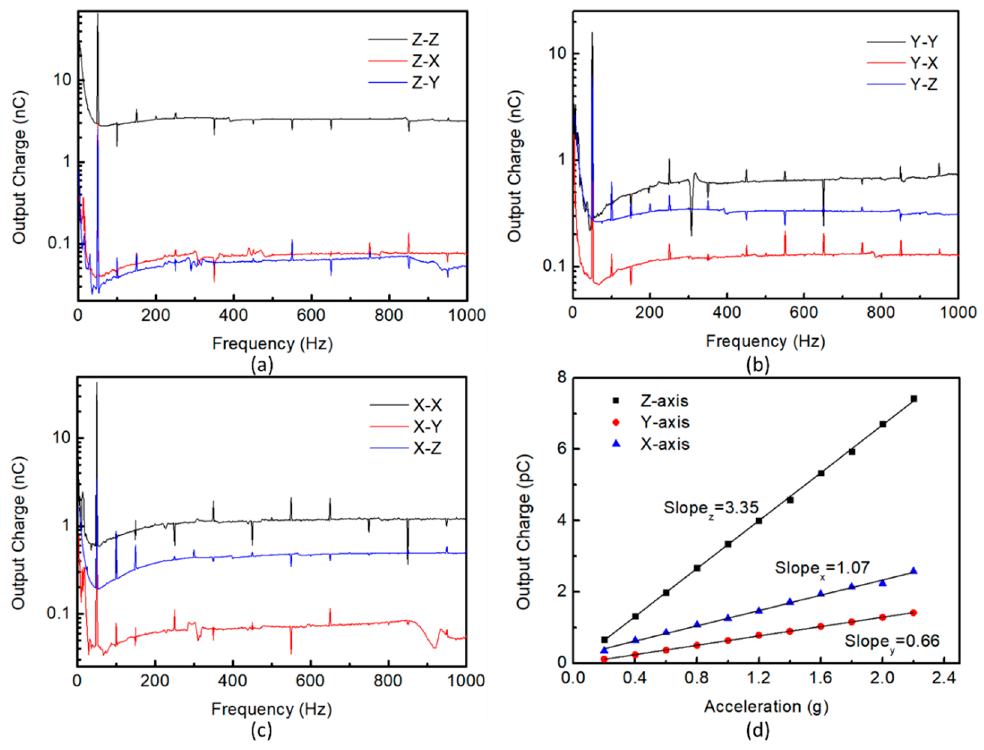
Figure 7. Output charge vs. frequency under 1g acceleration in the frequency range of 3 Hz–1 kHz: ( a ) Z–Z (Terminal Z/ z -axis acceleration), Z–X (Terminal Z/ x -axis acceleration), Z–Y (Terminal Z/ y -axis acceleration) ( b ) Y–Y (Terminal Y/ y -axis acceleration), Y–X (Terminal Y/ x -axis acceleration), Y–Z (Terminal Y/ z -axis acceleration) ( c ) X–X (Terminal X/ x -axis acceleration), X–Y (Terminal X/ y -axis acceleration), X–Z (Terminal X/ z -axis acceleration); ( d ) The output charge of the accelerometer